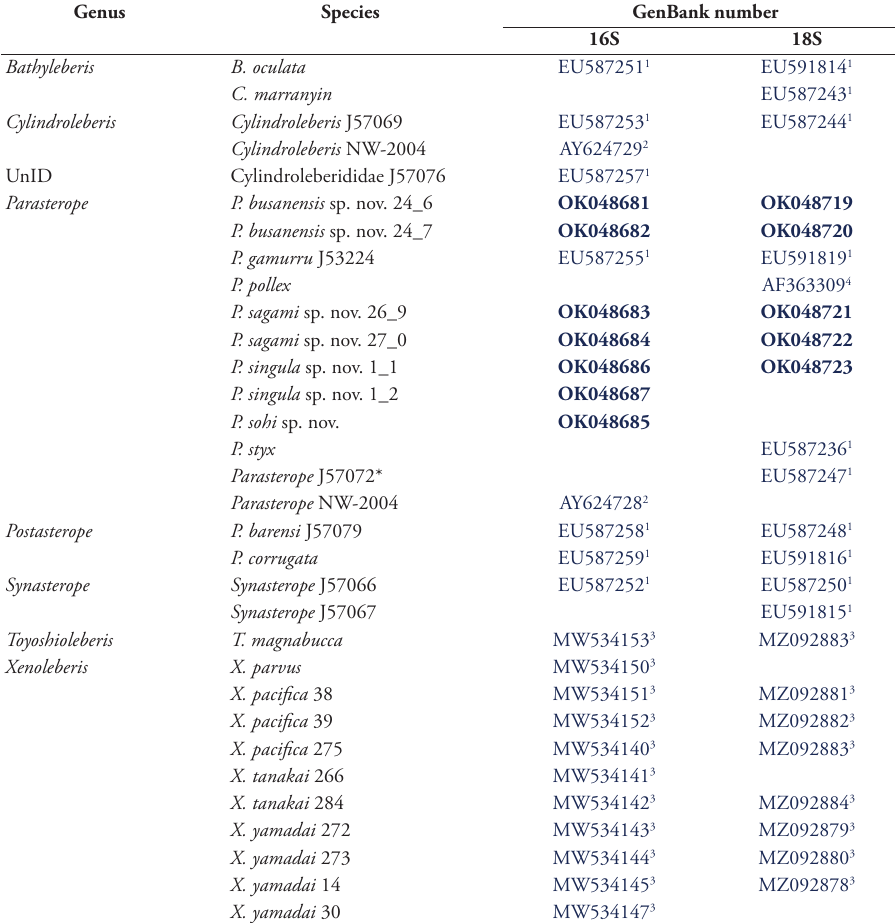
Table 1. List of 16S sequences used for phylogenetic analysis. 1 Syme and Oakley (2012); 2 Wakayama and Abe (2006); 3 Pham et al. (2021); 4 Oakley and Cunningham (2002); numbers in bold indicate se- quences from this